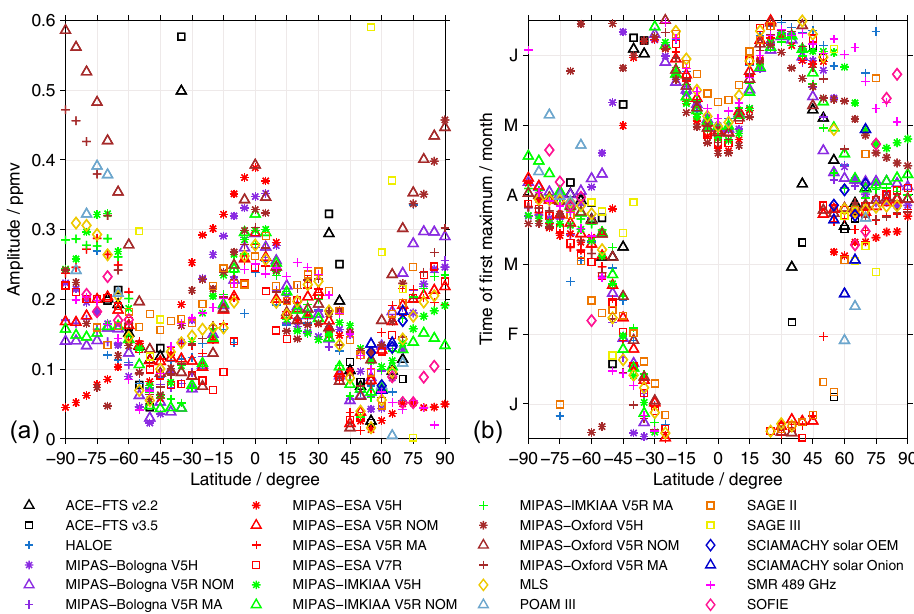
Figure 9. The latitude distribution of the semi-annual variation at 2.4hPa, close to the pressure level where the tropical semi-annual variation peaks as shown in Figs. 6 and